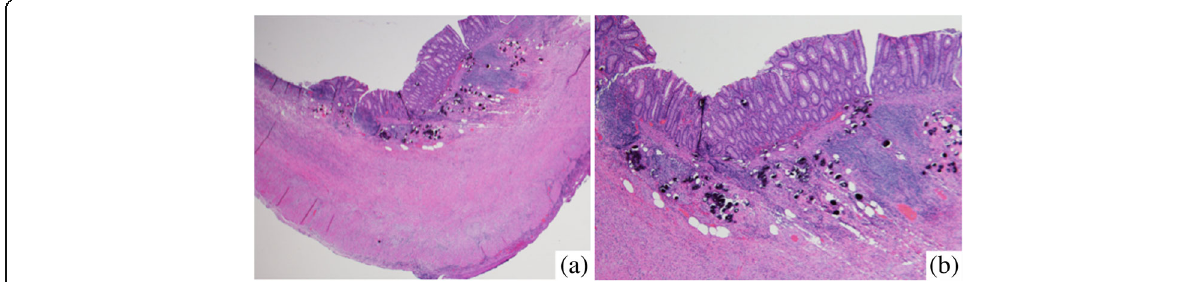
Fig. 3 The histopathology of the appendectomy specimen. Inflammation of the appendix wall was observed and numerous ovoid bodies, many of which were calcified, were present within the submucosa. a low (× 40) and b high (× 100) powered magnification (H&E staining)